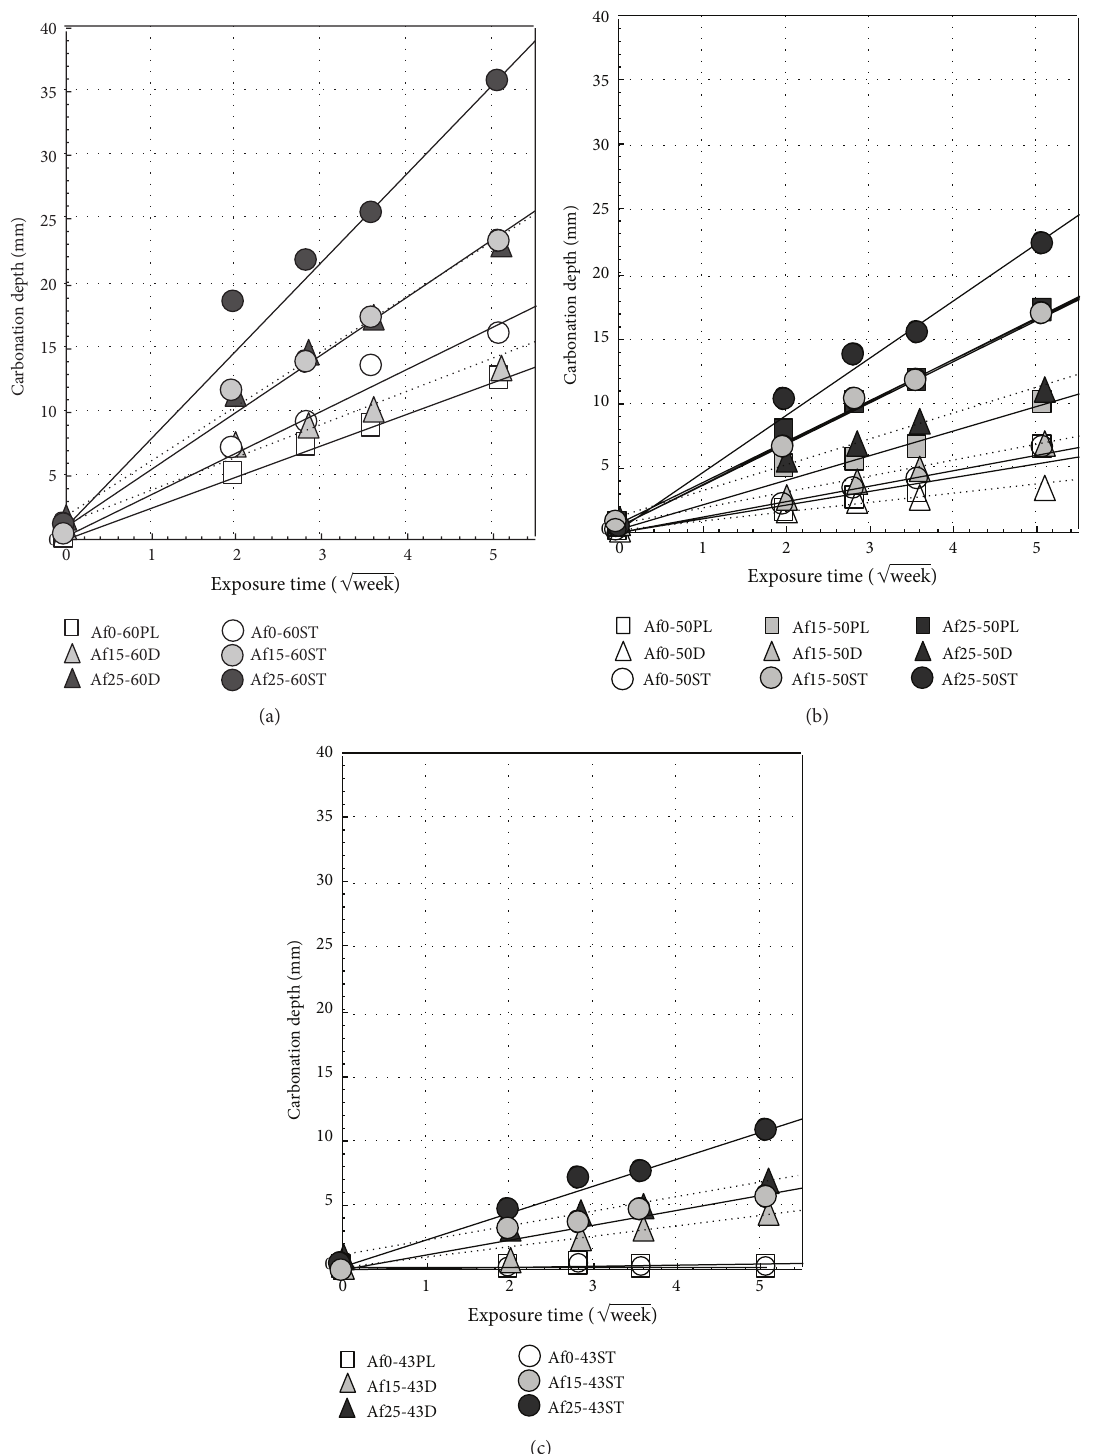
Figure 8: Carbonation depth by accelerating carbonation (at 5% CO 2